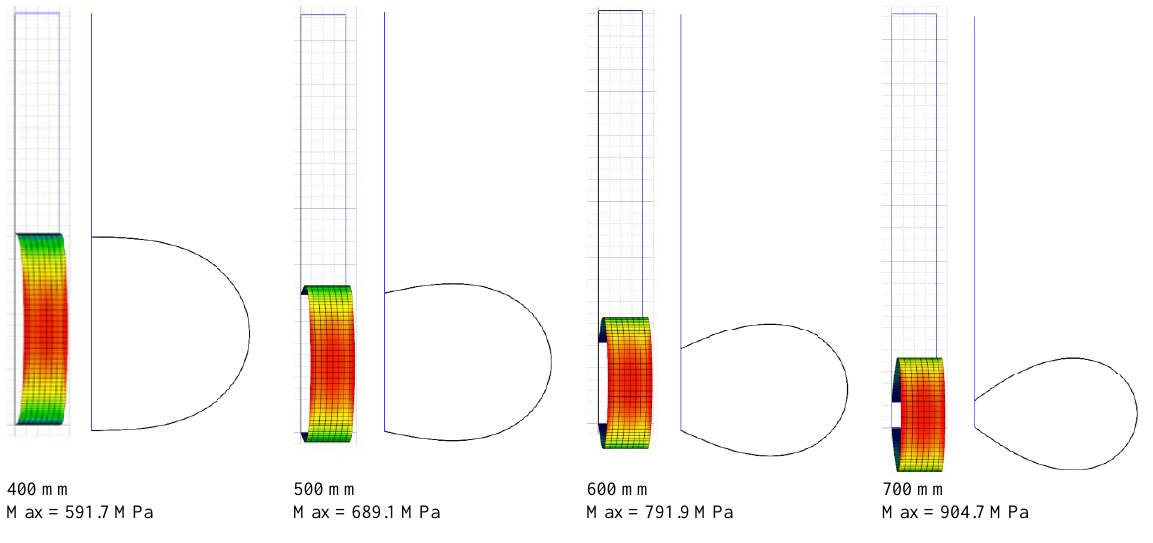
Fig. 11 Side view of the plate deformation and 3D view of principal stress σ 1 along its vertical deformation Concerning the applied force, the experimental data was obtained with the compression machine and showed remarkable consistency (Fig. 11). The numerical results present slight differences compared to experimental data, particularly regarding the triggering of instability. For both experimental and numerical data, buckling starts at around the same applied force, but while experimental results reveal an increase of force and then a sudden drop with the buckling (which can be due to friction effects), the numerical results initially present a lower force with a much smoother increase of deformation. Then, the behaviour stabilizes and the curves become almost parallel, with an offset of around 5.5 N to 6.5 N. It is worth mentioning that the overall behaviour reflected by the experimental and numerical curves is consistent with the (expected) stable buckling behaviour of an elastic material.